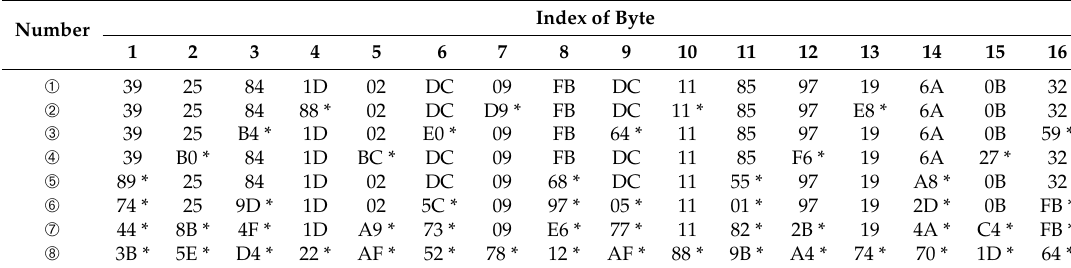
Table 2. Experimental results.